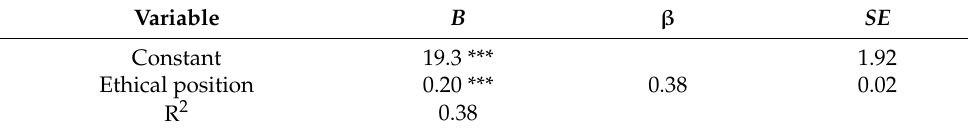
Table 6. Regression coefficient of ethical position on animal attitude (N = 450). Variable